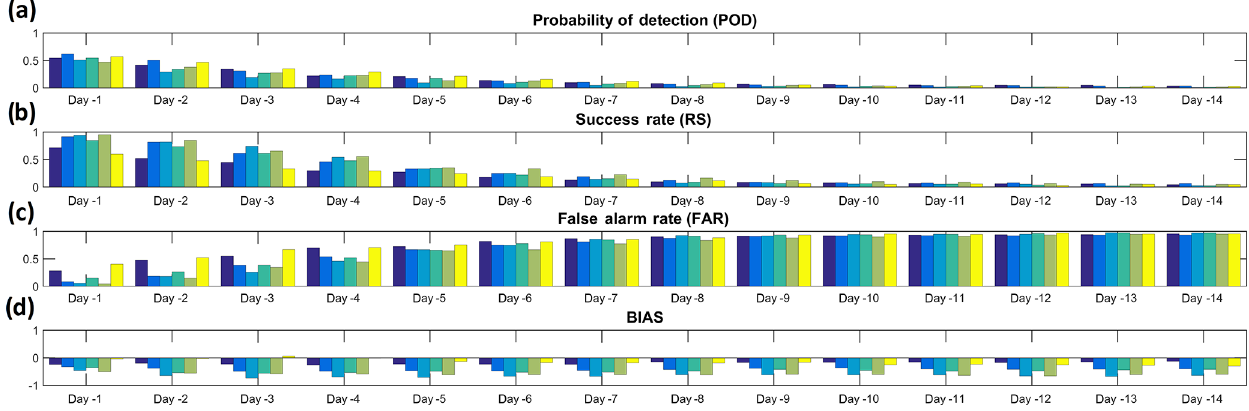
Figure 9. Forecast verification metrics for IVT exceedances ( > 450kgm − 1 s − 1 ) using the ECMWF ensemble forecast system during the extended winters of 2012–2016 in western Iberia, and for lead times between 1 and 14d are presented. Colored bars represent metrics for individual regional boxes, where the darkest blue bar represents the northernmost box and the yellow bars the southernmost box (as depicted in Fig.